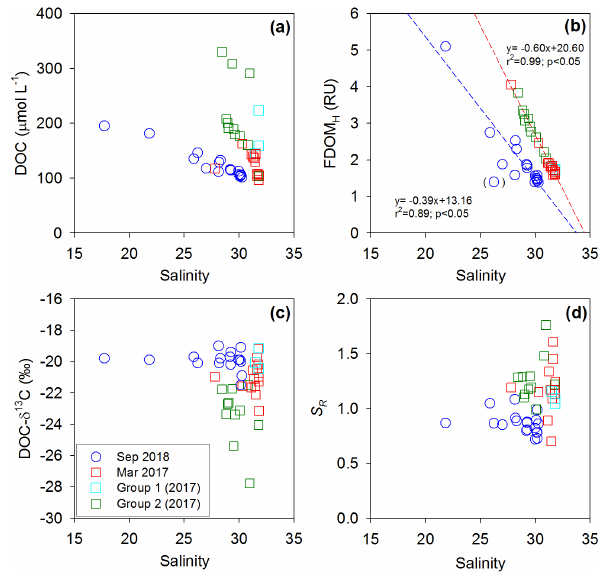
Figure 4. Plots of salinity versus (a) DOC concentrations, (b) FDOM H concentrations, (c) DOC- δ 13 C values, and (d) S R val- ues in Sihwa Lake in March 2017 (red square) and September 2018 (blue circle). The dashed lines represent the regression lines.